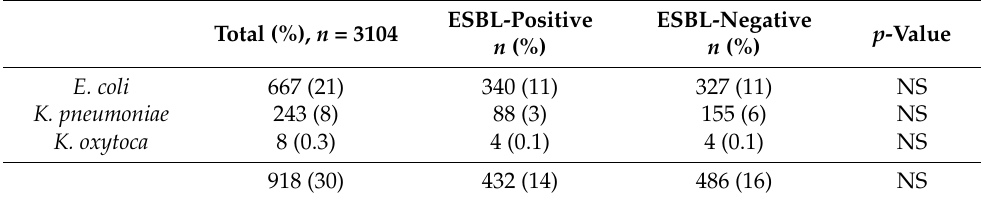
Table 2. Enterobacterales carriage among 3104 samples from pregnant